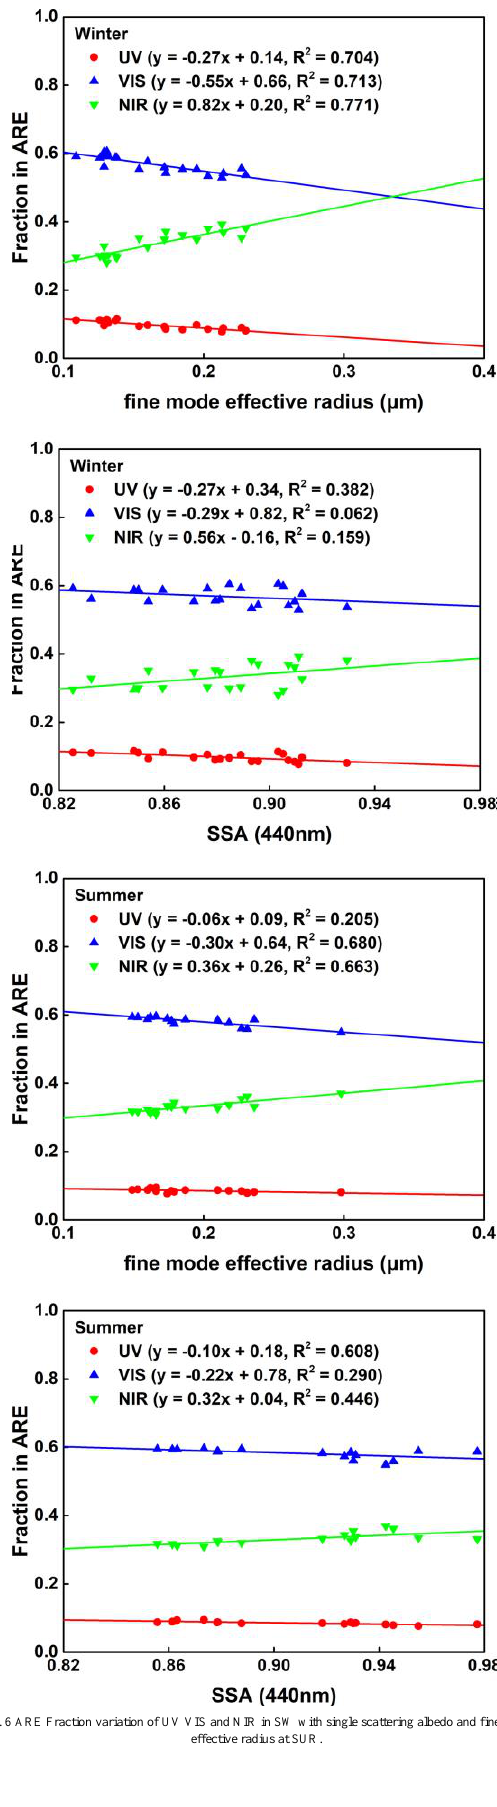
Fig. 6 ARE Fraction variation of UV VIS and NIR in SW with single scattering albedo and fine mode effective radius at